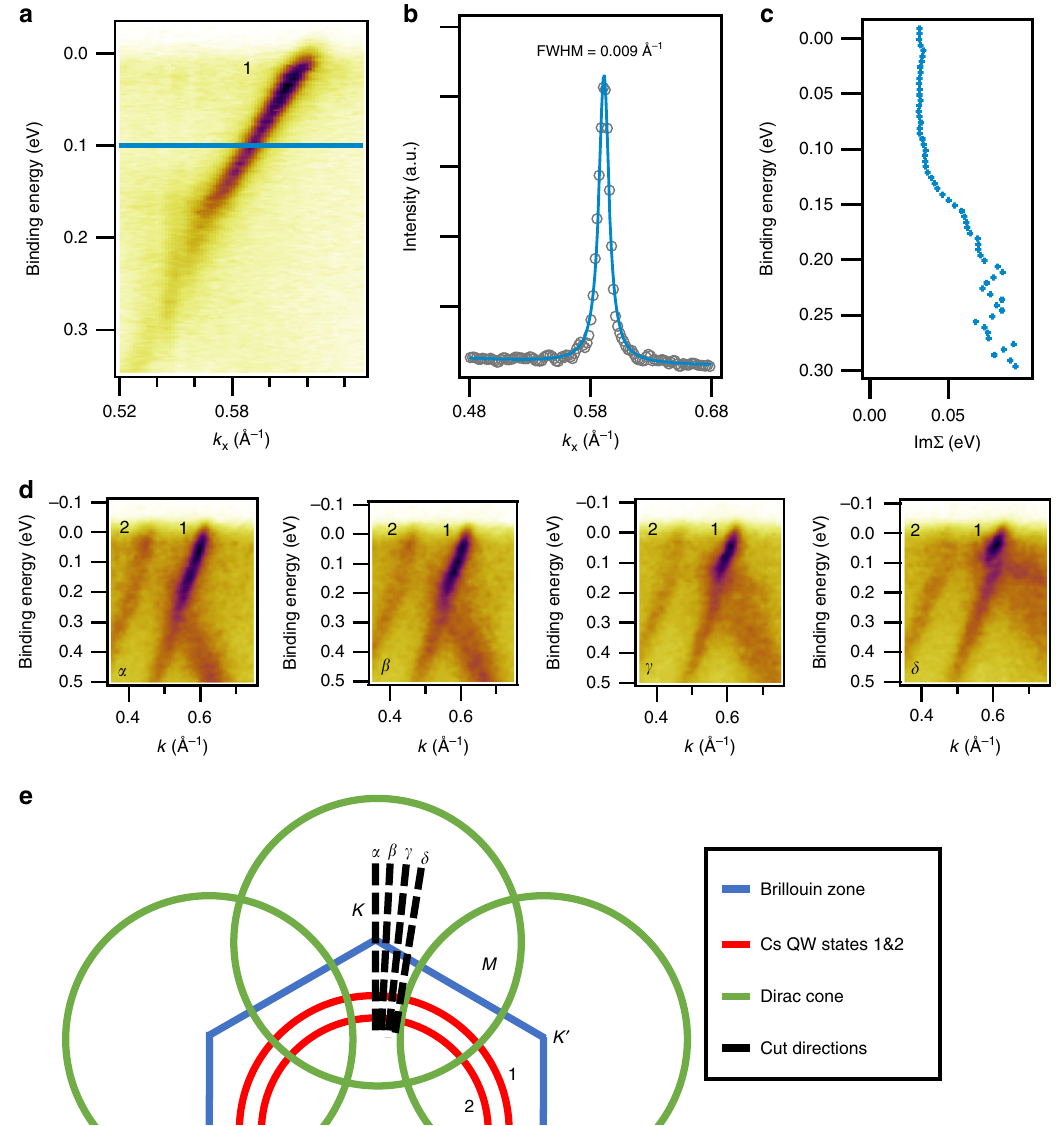
Fig. 4 Self-energy analysis of the quantum well state. a High-resolution ARPES scan ( h ν = 31 eV, T = 20 K) of the deepest Cs quantum well state. b Momentum distribution curve of the cut at E = E F − 0.1 eV. c Imaginary part of the self-energy ℑ Σ ( E ) as a function of binding energy E . d Region where quantum well state bands 1 and 2 cross with the graphene band. Scans α − δ shown are radial cuts for different angles around the Γ points in steps of 3 degrees. e Sketch of the Fermi surface and the cuts α − δ of d